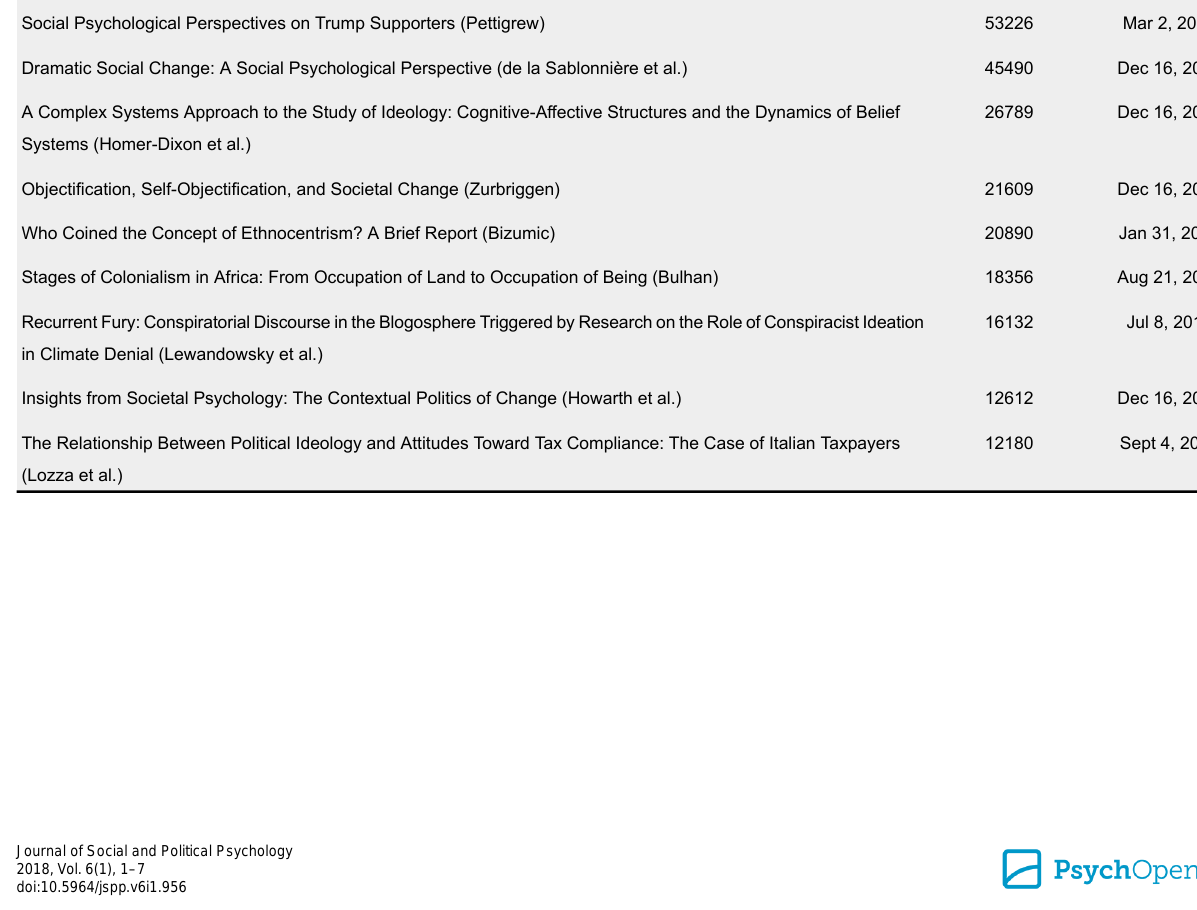
The top ten most frequently downloaded articles (as of 2 March 2018) are listed in Tables 3 and 4. Table 3 includes